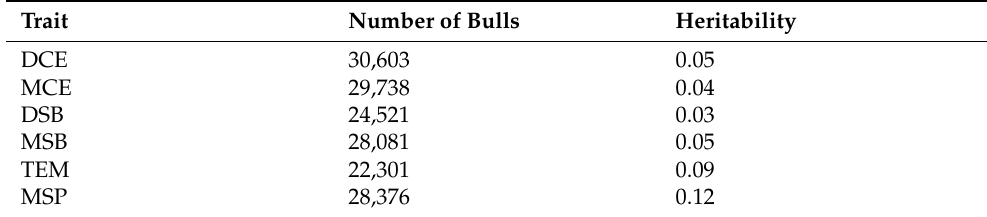
Table 1. Number of bulls and heritability.